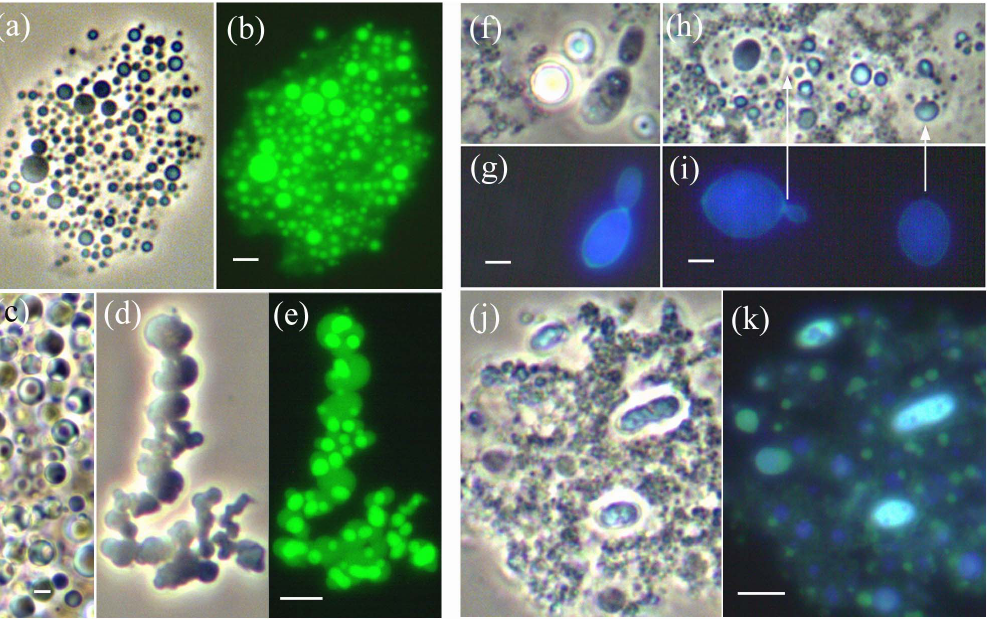
Figure 10. Mycosomes from egg yolk revert to walled cells. (a–b) Yolk-Ms show prolific reproduction within thin membrane sacs. (a) Phase contrast, (b) SYTO 9 stain. (c) IAA-treated Ms formed large membrane-sacs containing numerous spheroid protoplasts, each with a prominent central body. (d–e) Ms cultured in MsM flooded over Sabouraud dextrose agar. The variable-shaped lipoid bodies (d) contain (e) fluorescing PMOs or Ms (SYTO 9 stain). (f–k) Cell wall formation by Rhodotorula glutinis stained for chitin with Fungi-Fluor. (f and h) Yeast cells were present at 38 days within a diffuse protoplast matrix containing lipoid-Ms (phase contrast). (g and i) Ms and the protoplast matrix do not express chitin; only the mature cell (g) and thin walled yeast cells (i) fluoresce. (j–k) Sampled two weeks later, three walled cells and many enlarging Ms show variable cell wall fluorescence. Bars =2.0 m m.